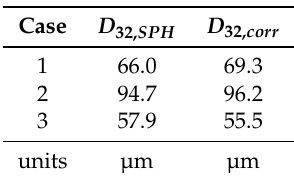
Sauter Mean Diameters of Smoothed Particle Hydrodynamics (SPH) simulations and experimental